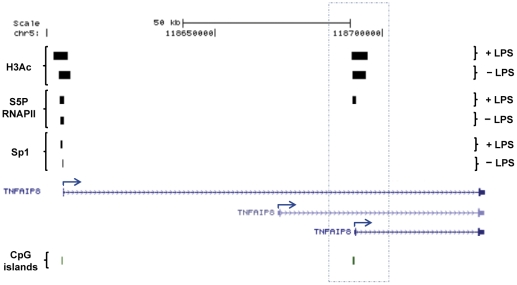
Group 2: Inflammatory up-regulated gene.
TNFAIP8 is a representative cytokine gene where a new S5P RNAPII binding appears in one of its annotated promoter/TSS. This gene has three alternatives annotated promoters/TSS. The largest transcript has H3Ac peaks, S5P RNAPII and Sp1 binding nearby the TSS. The shortest transcript also harbours an H3Ac signal in its annotated TSS and an inducible S5P RNAPII signal upon LPS stimulation while the medium transcript does not fulfil the group 2 features. Genes identified by RefSeq using the UCSC browser are shown with blue arrows indicating TSSs locations and directions (GRCh37/hg19).